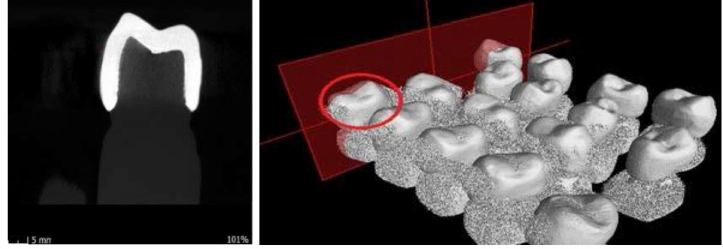
Figure 7. Images from the micro-CT program—ZLSP samples.